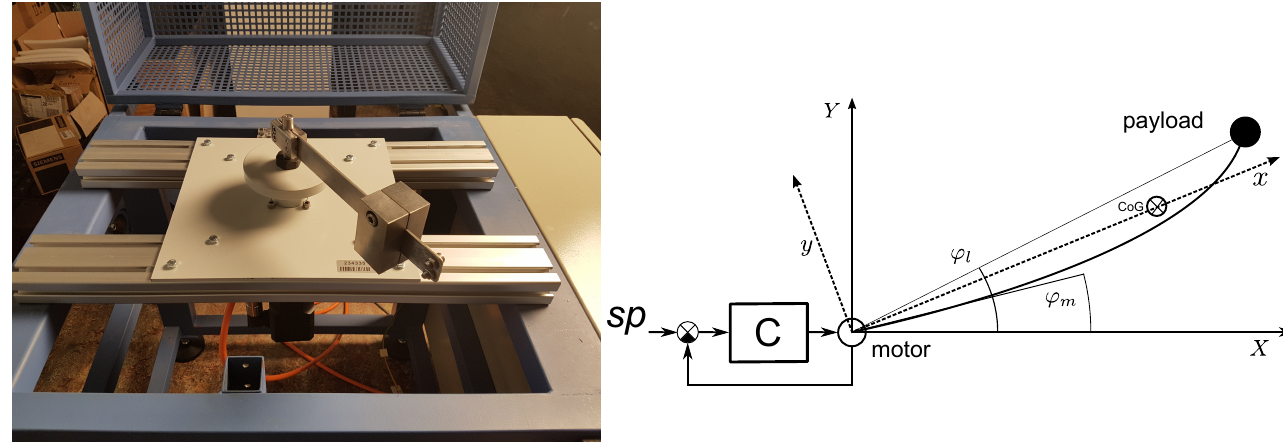
Figure 1. Flexible arm motion stage used in the experiments: ( left ) Considered flexible load configuration; ( right ) Schematics of the motion control setup, C-velocity/position compensator to be designed using the motor-side feedback, ϕ m , ϕ l -motor and load angle.